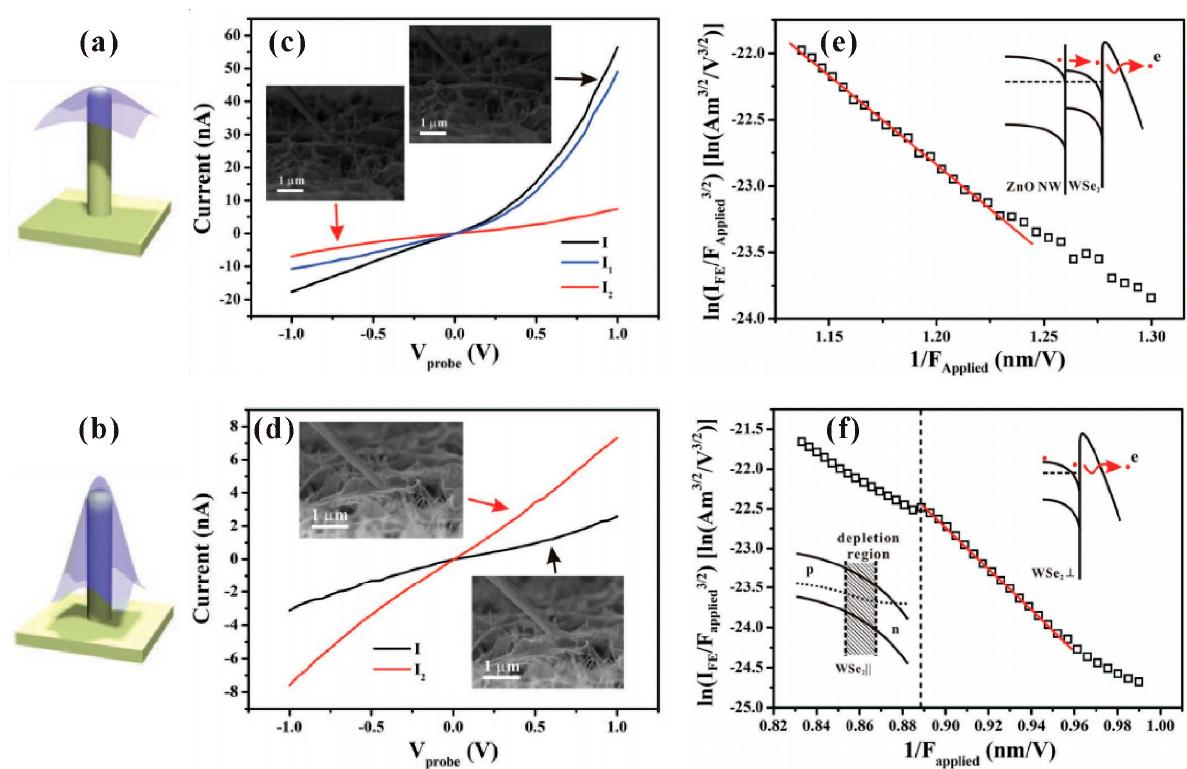
Figure 26. Schematic diagram for the “tip-contact” ( a ) and “edge-contact” ( b ) structures of WSe 2 -ZnO nanowire. Typical electrical characteristics of the “tip-contact” ( c ) and “edge-contact” ( d ) structures of WSe 2 -ZnO nanowire. Typical field emission FN plots of the “tip-contact” ( e ) and “edge-contact” ( f ) structures of WSe 2 -ZnO nanowire. Reproduced from [99], with the permission of John Wiley and Sons, 2019.